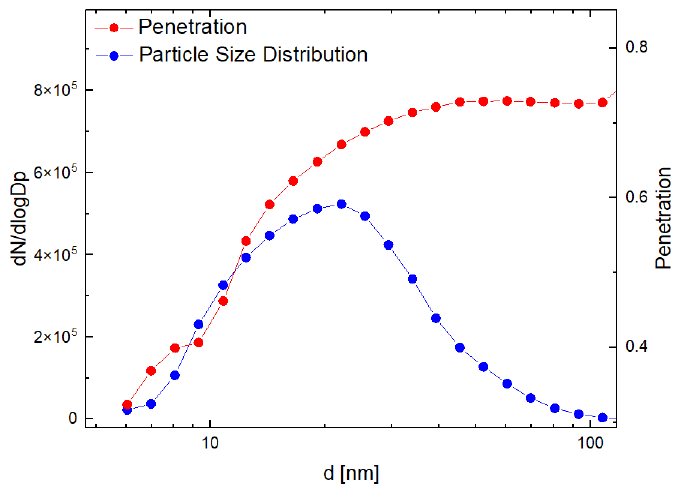
Figure A2. Graphite test particles were produced by a solid particle generator from Palas using the following settings: 2500 V, 50 Hz, Air: 50 L/min, N2: 5 L/min. The penetration of solid particles through the catalytic stripper was calculated as the ratio of particle concentrations with and without the catalytic stripper at 350 °C upstream of the EEPS.